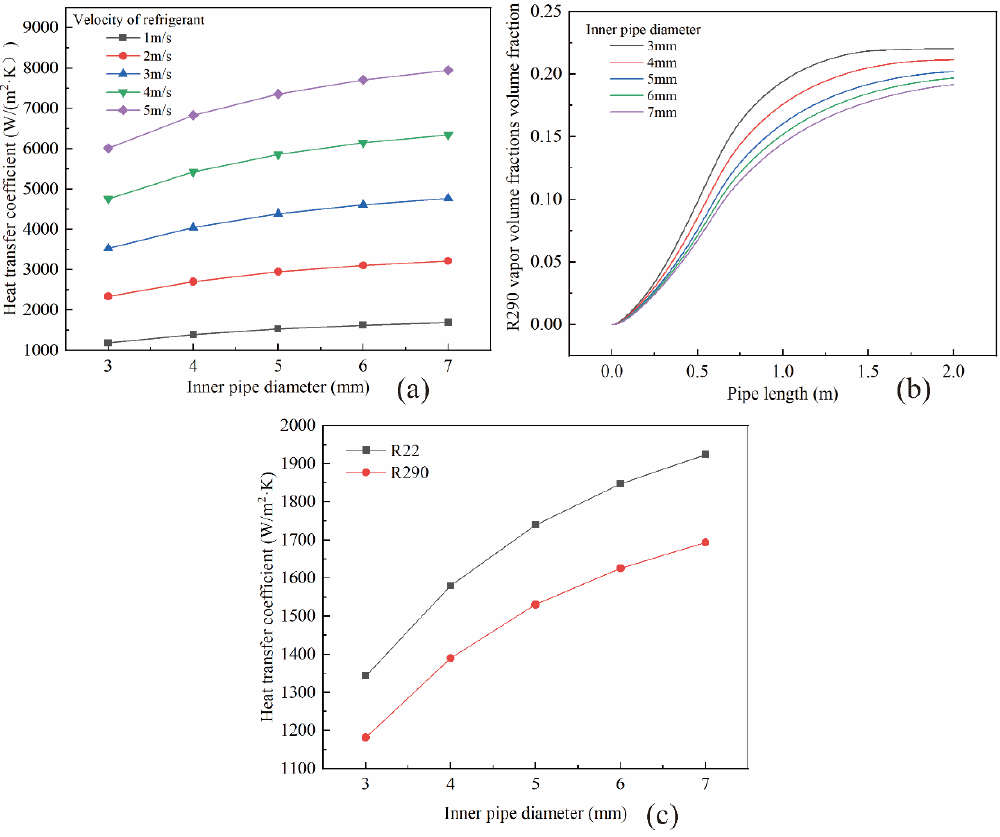
Figure 5. The impact of ( a ) inner pipe diameter on HTC, ( b ) R290 volume fraction at the inner tube wall surface and ( c ) HTC for R22 and R290 at different pipe diameters.